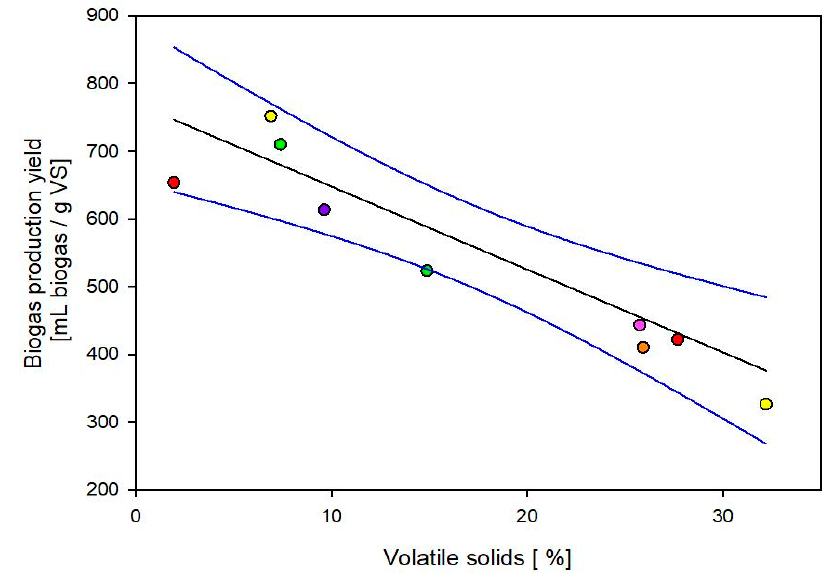
Figure 2. Variation in the biogas production yield as a function of the % VS of the annexed distilleries in Colombia. Triplicates from the same sample are represented by circles. Circles with the same color indicate samples from the same plant. The blue line represents a confidence level of 95%.